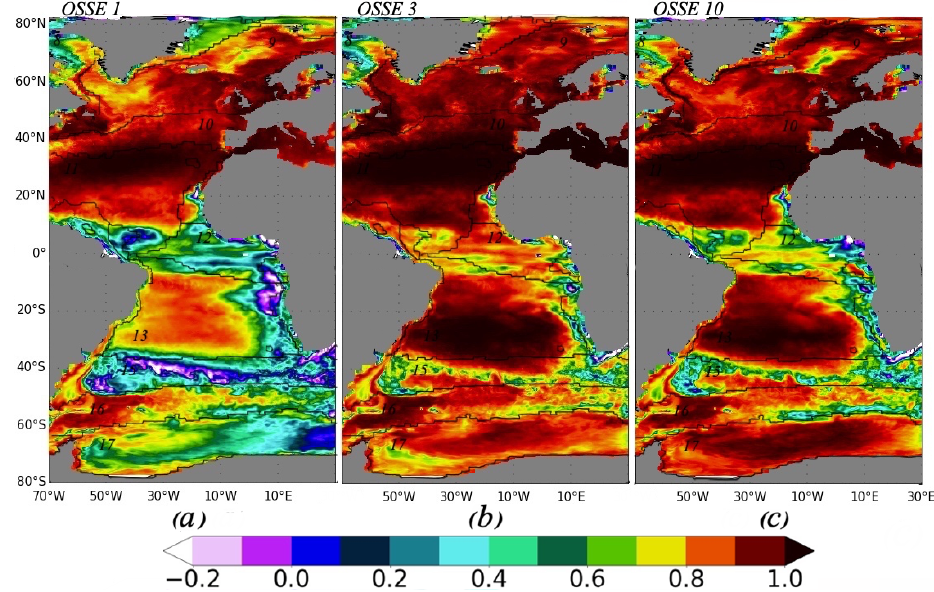
Figure 6. Correlation coefficient between OSSE FFNN outputs and NEMO/PISCES p CO 2 : (a) OSSE 1 using SOCAT data only; (b) OSSE 3 using SOCAT and synthetic Argo data; and (c) OSSE 10 using SOCAT data, 25% of the original synthetic Argo data in the Southern Hemisphere, and data from mooring stations. Contours and numbers on maps correspond to biomes. Table 6. Correlation coefficient between OSSEs and NEMO/PISCES p CO 2 . OSSE Region Biome 80 ◦ S–80 ◦ N, All eight biomes 9 10 70 ◦ W–30 ◦ E OSSE 1 0.68